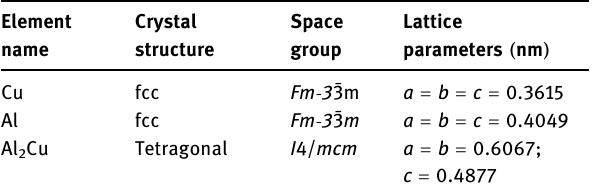
Table 1: Crystal structures of Cu, Al and Al 2 Cu